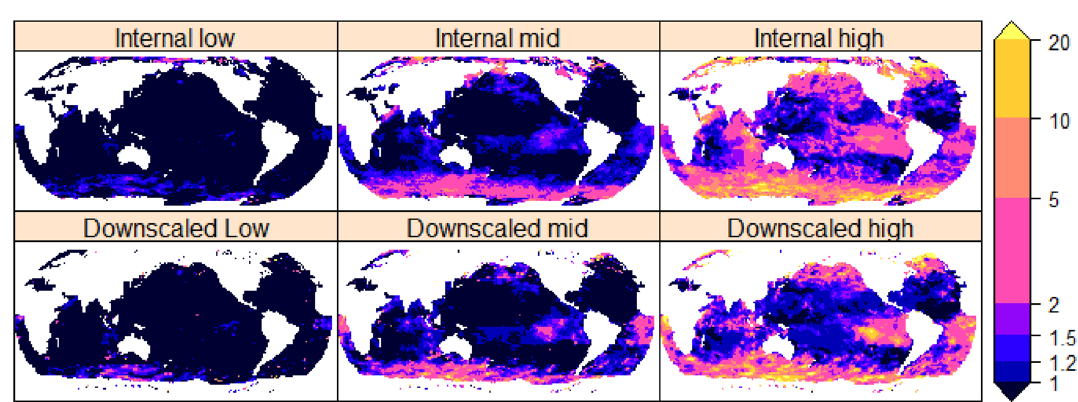
Figure 5. GEV RCP85 amplification of the baseline 1% AEP over a period of 100 years. Log colour scale indicates the amplification factor. Top row: Internal model estimates using GWCM GEV parameters, bottom row: Downscaled estimates using the hindcast GEV parameters with the incremental change to the location parameter ( δ H m0 ). Created using the R statistical software version 4.0.2 22 .